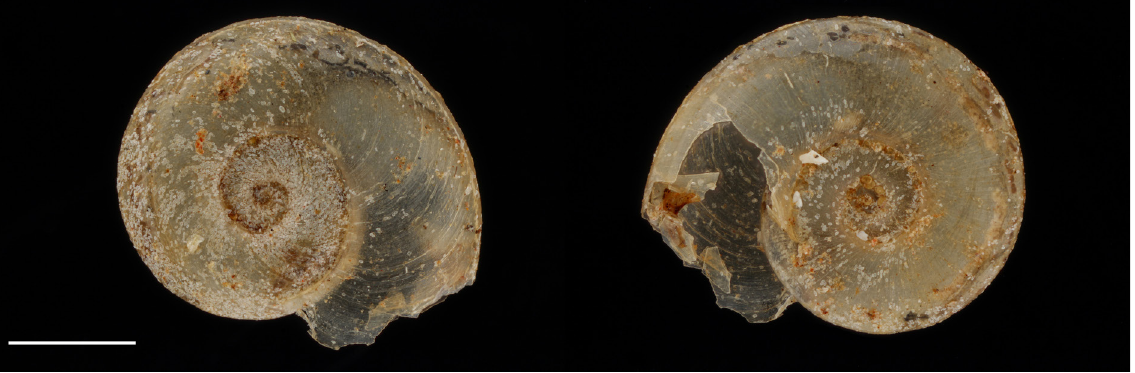
Fig. 2.6. Translucent specimens. Pictures of a small translucent specimen of Gyraulus costulates exilis . Scale = 1 mm.